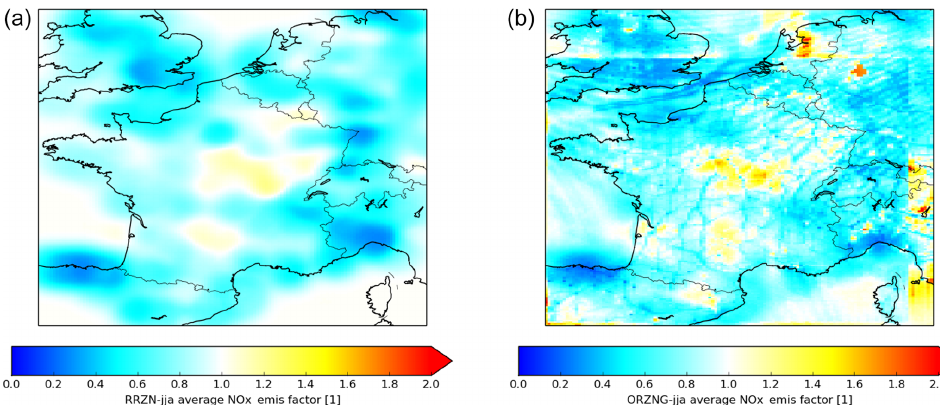
Figure 16. Average NO x emission increment for the run with assimilation of ground-based ozone observations only (RR) (a) and the S4 assimilation run (b) for the summer study period over the zoom